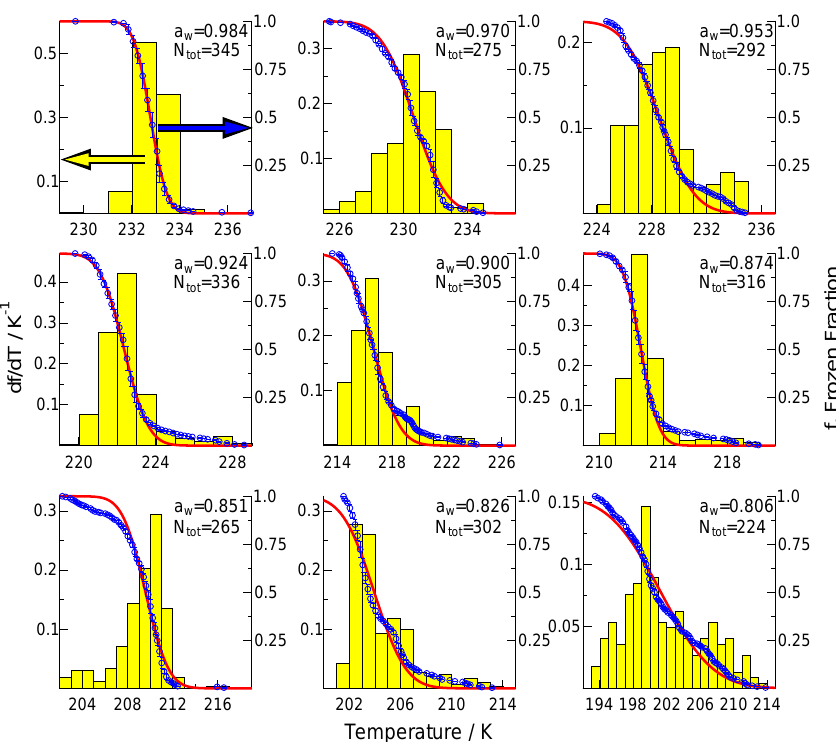
Fig. 2. Summary of all observed homogeneous ice nucleation events as a function of a w and T . The frozen fraction, f , of droplets in 0.2K temperature increments is represented by blue circles. Error bars indicate the range of f in a temperature increment of 0.2K. Yellow bars show the probability density histogram (PDH) binned in 1.0K increments. For each panel, a w and the total number of analyzed droplets, N tot , are given. The values for the PDH are given on the left y -axis and f on the right y -axis.